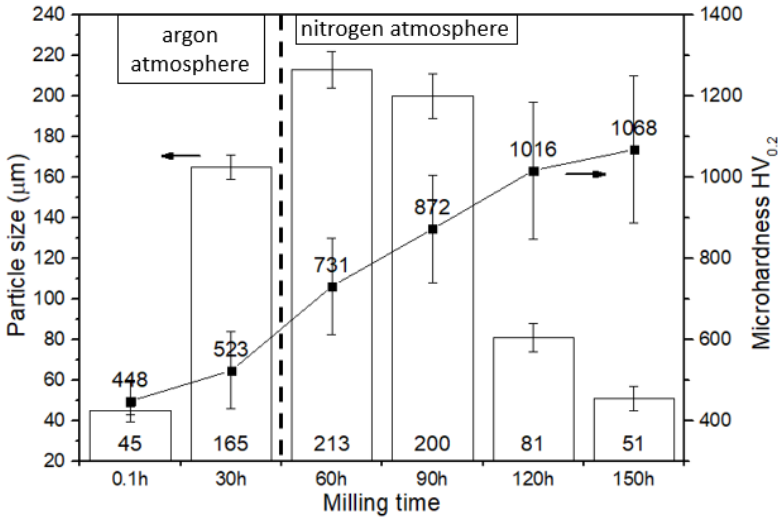
Figure 4. The particle size and microhardness of powders at different milling times.